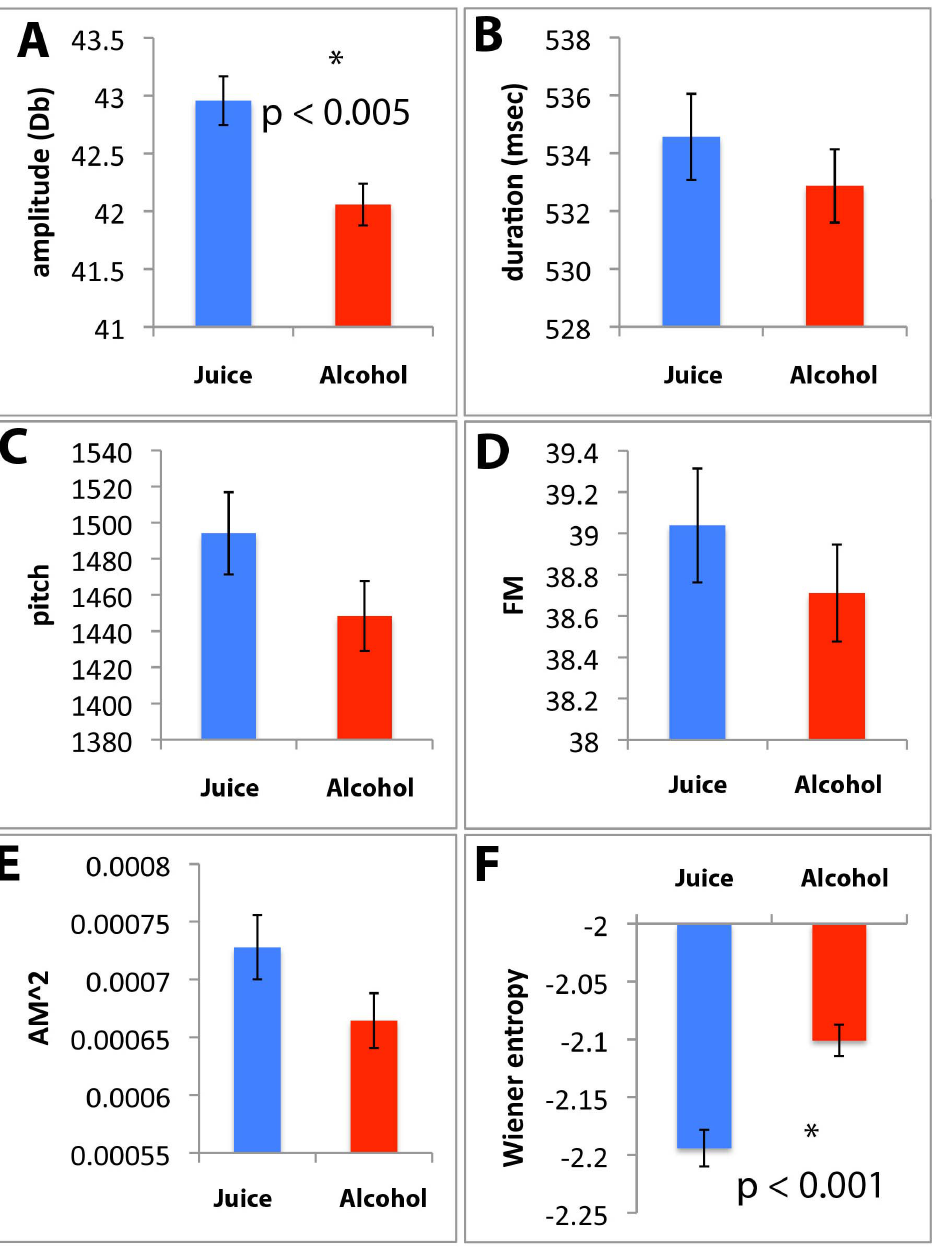
Fig. 4. Effects of alcohol drinking on song acoustic features. Plotted are the values of least-square means of each acoustic feature (A–F) from whole- motif measurements of all individuals; error bars are standard errors of the means. * indicates a significant